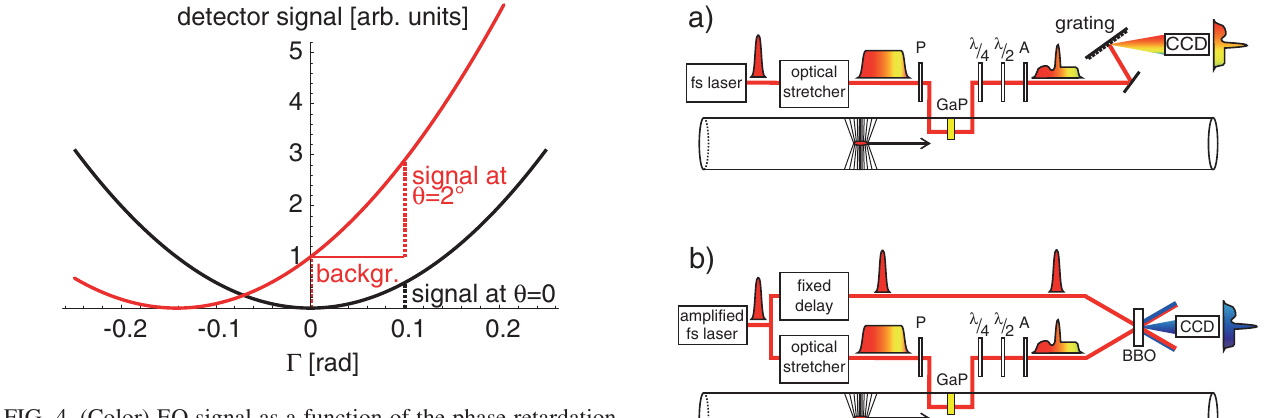
FIG. 4. (Color) EO signal as a function of the phase retardation (cid:1) for two orientation angles of the half-wave plate: (cid:6) ¼ 0 , and (cid:6) ¼ 2 (cid:3)